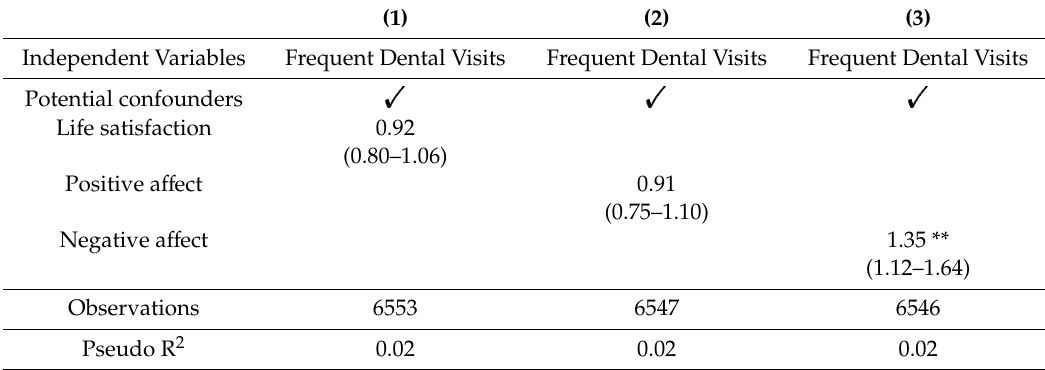
Table 4. Determinants of frequent dental visits (0 = Non-frequent dental visits; 1 = Frequent dental visits; cut-o ff at the highest 5%). Results of multiple logistic regressions 1